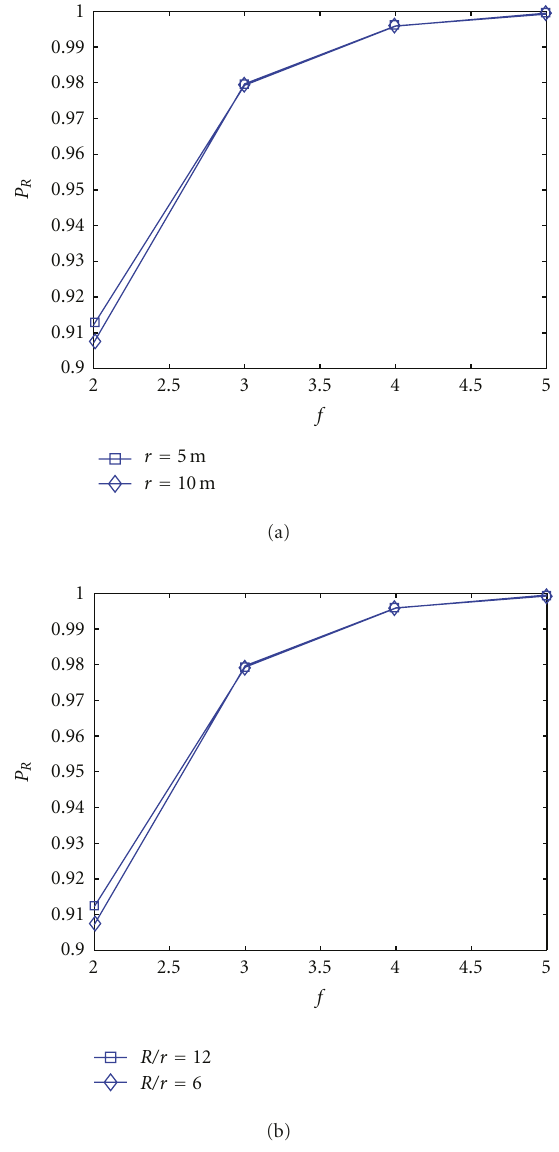
Figure 9: P R versus f when r = 5m and r = 10 m (a), and for di ff erent values of R/r